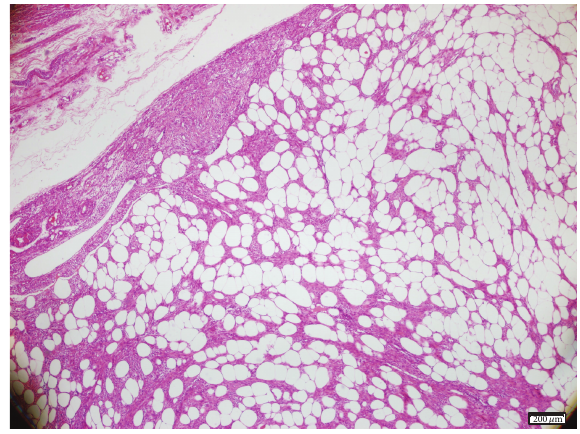
Figure 3: Diffuse positivity with alpha-smooth actin ×